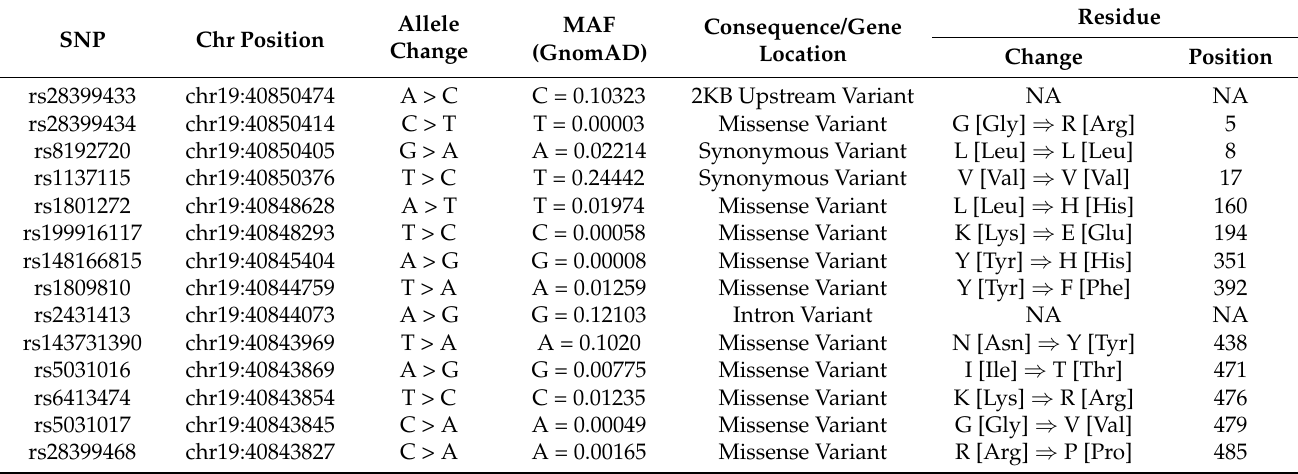
Table 1. Molecular characteristics and frequencies for SNPs in CYP2A6 related to the enzymatic activity.